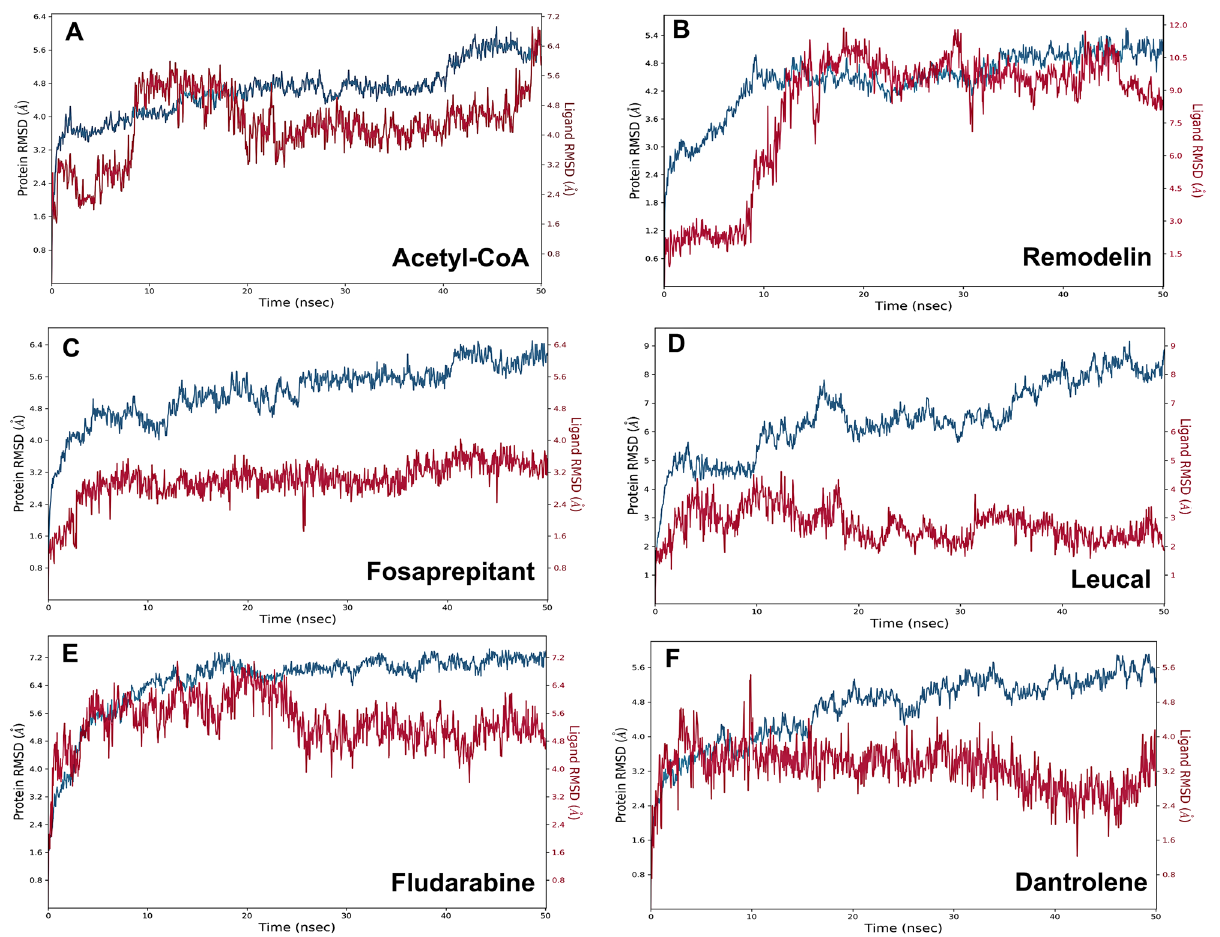
Figure 3. The Root Mean Square Deviation (RMSD) plots of ligands interacting with NAT10. RMSDs for ( A ) Acetyl-CoA ( B ) Remodelin ( C ) Fosaprepitant ( D ) Leucal ( E ) Fludarabine ( F ) Dantrolene. Blue colour represents NAT10 backbone fluctuations; red represents ligand